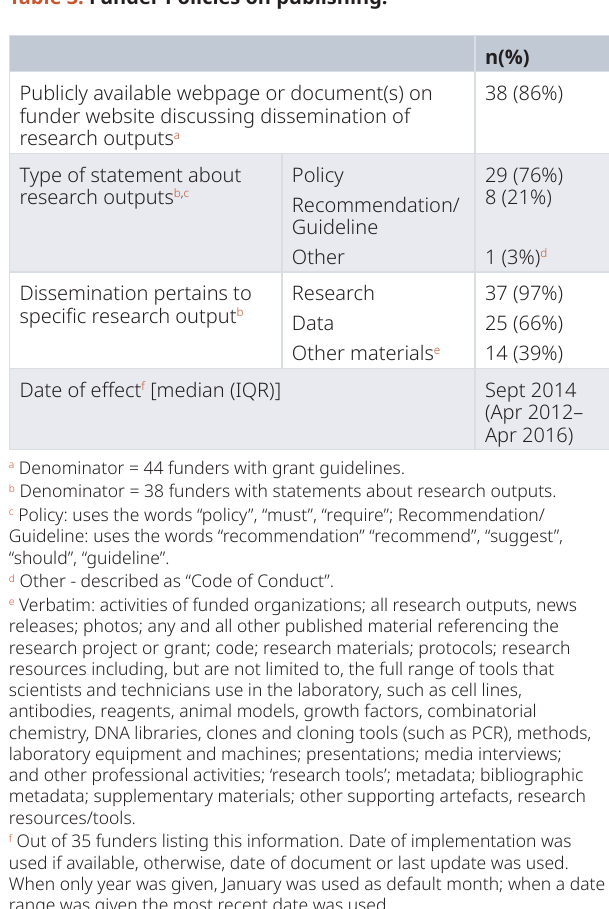
Table 2. Description of funders (n=44). Table 3. Funder Policies on